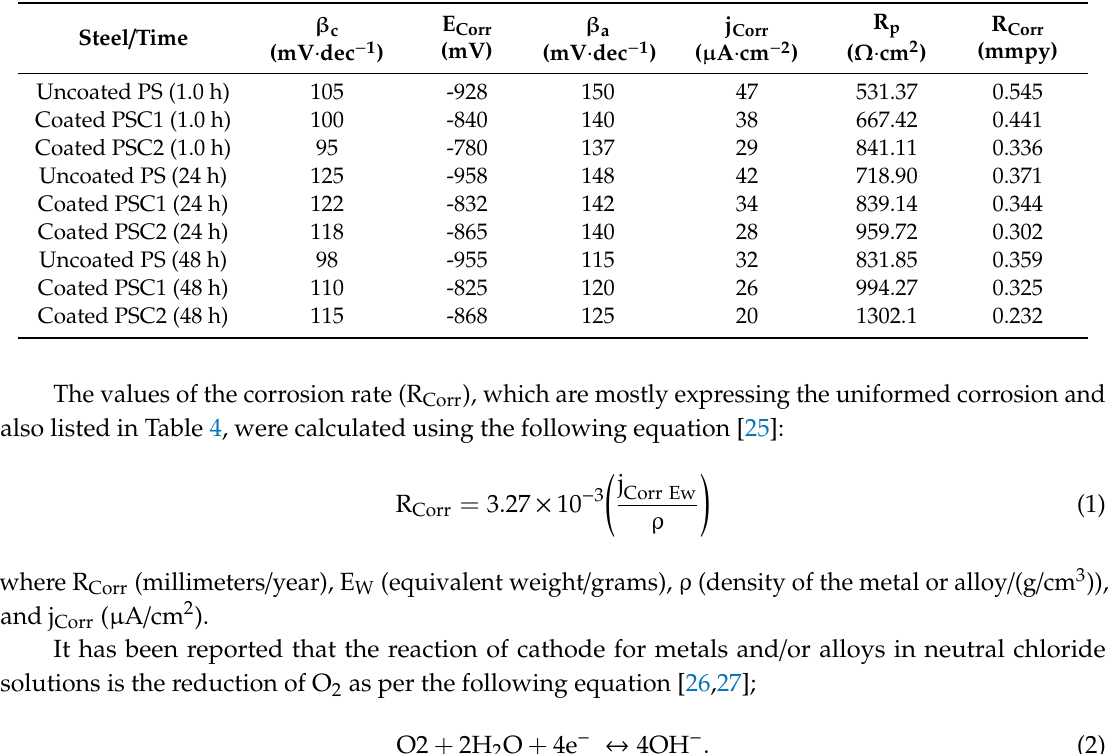
Table 4. Polarization (CPP) data obtained for the PS, PSC1, and PSC2 samples after the di ff erent immersion periods in NaCl